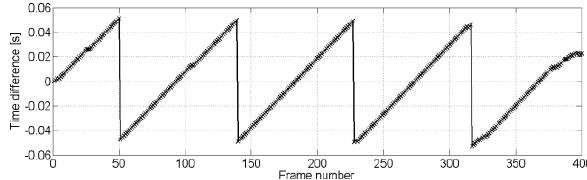
Figure 2. Difference between theoretical and recorded time of the camera shutter release